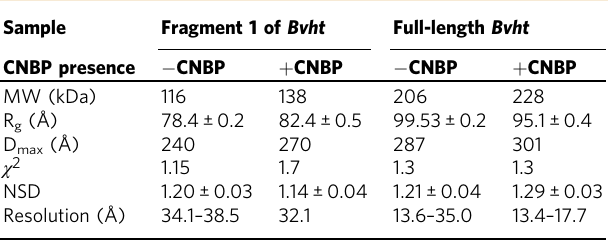
Table 4 Dependence of Bvht structures on CNBP protein (22 kDa) binding (6 mM Mg 2 +